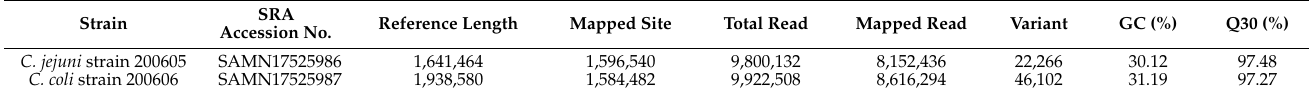
Table 3. Genome characteristics and accession numbers of C. jejuni and C. coli strains. Strain SRA Accession